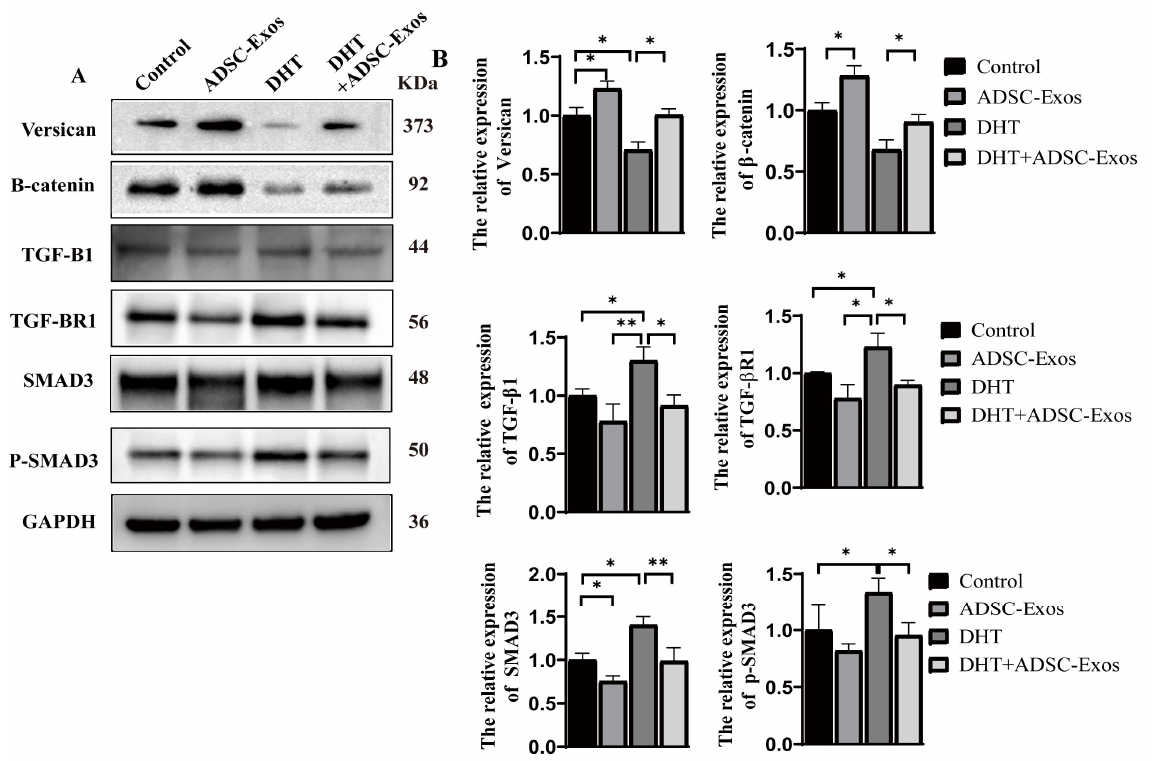
Figure 2. ADSC-Exo mitigated the inhibitory effect of DHT on DPCs. ( A ) The protein expression of the TGF- β /SMAD axis, its downstream genes, and proliferation-regulating genes in DPCs induced by DHT (10 − 5 mol/L). ( B ) Relative expression levels of proteins. Normal human DPCs treated with PBS were used as control. Data are represented as means ± SEM. * p < 0.05, ** p < 0.01.